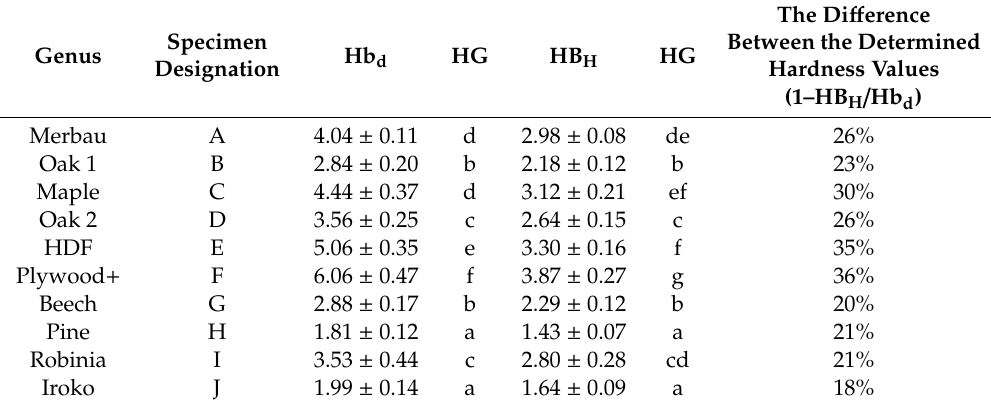
Table 2. Results of hardness measurements based on indentation diameter (HB d ) and indentation depth (HB H ) and homogeneous groups.